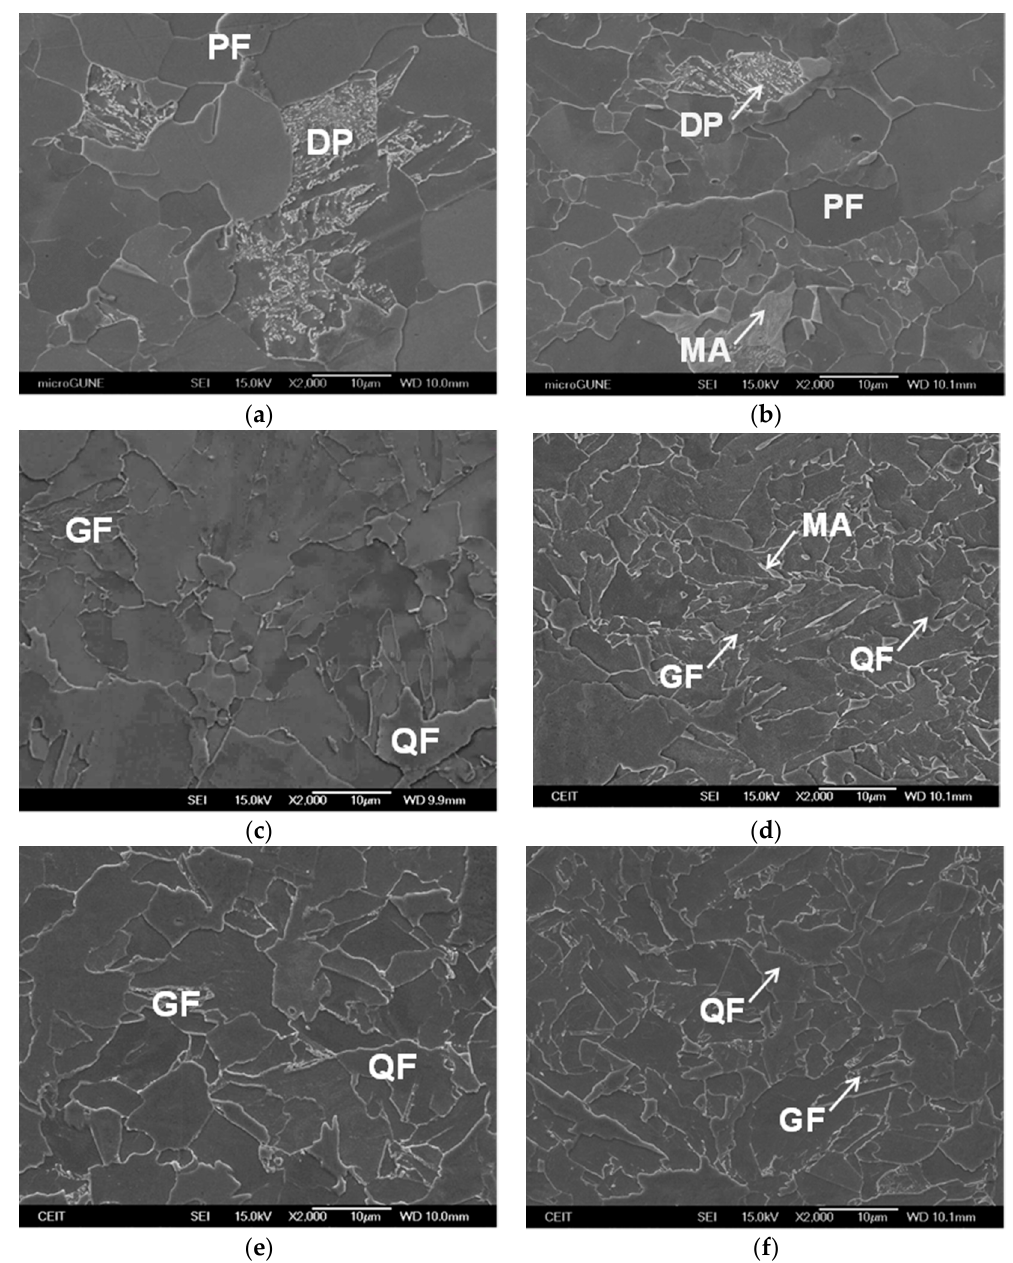
Figure 3. Typical FEG-SEM micrographs corresponding to S401 (Nb) steel ( a , c , e ) and S404